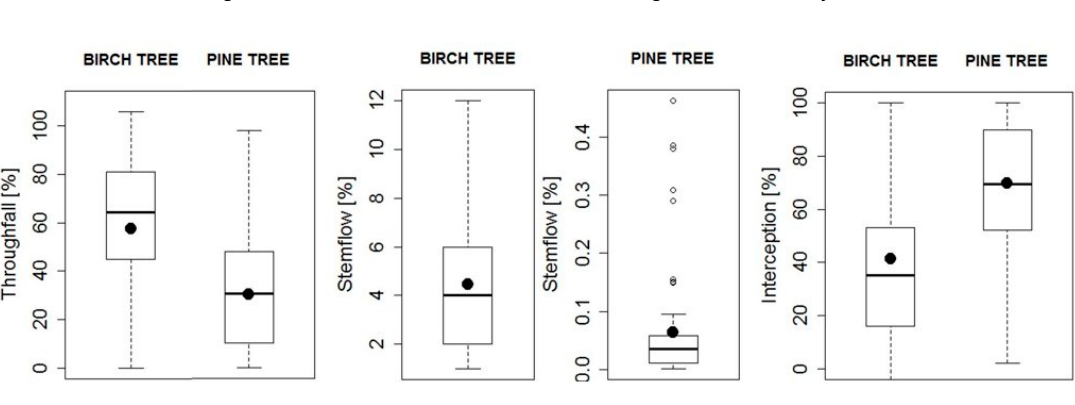
Figure 3. Box-and-whiskers plot of throughfall, stemflow and rainfall interception under birch and pine trees (note different scale for